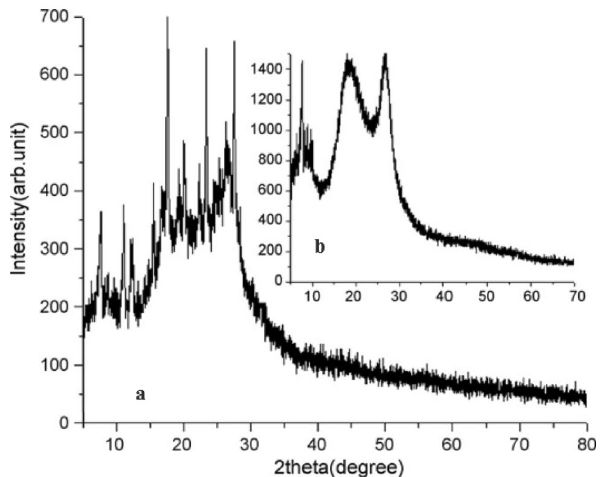
Fig. 6 XRD of nanorod PIN ( a ) and microsphere PIN ( b )